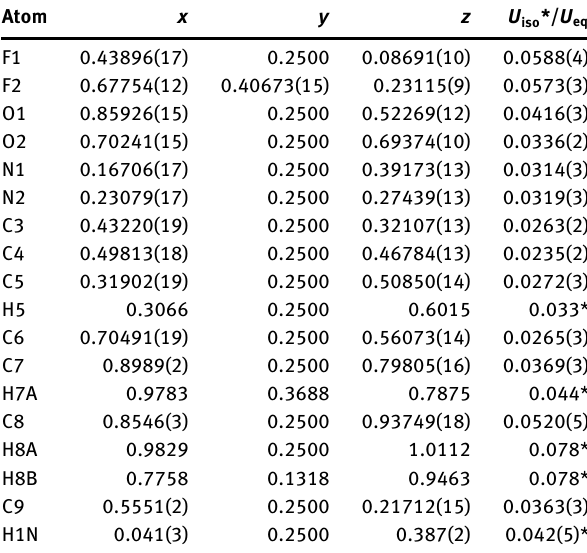
Table 2: Fractional atomic coordinates and isotropic or equivalent isotropic displacement parameters (Å 2